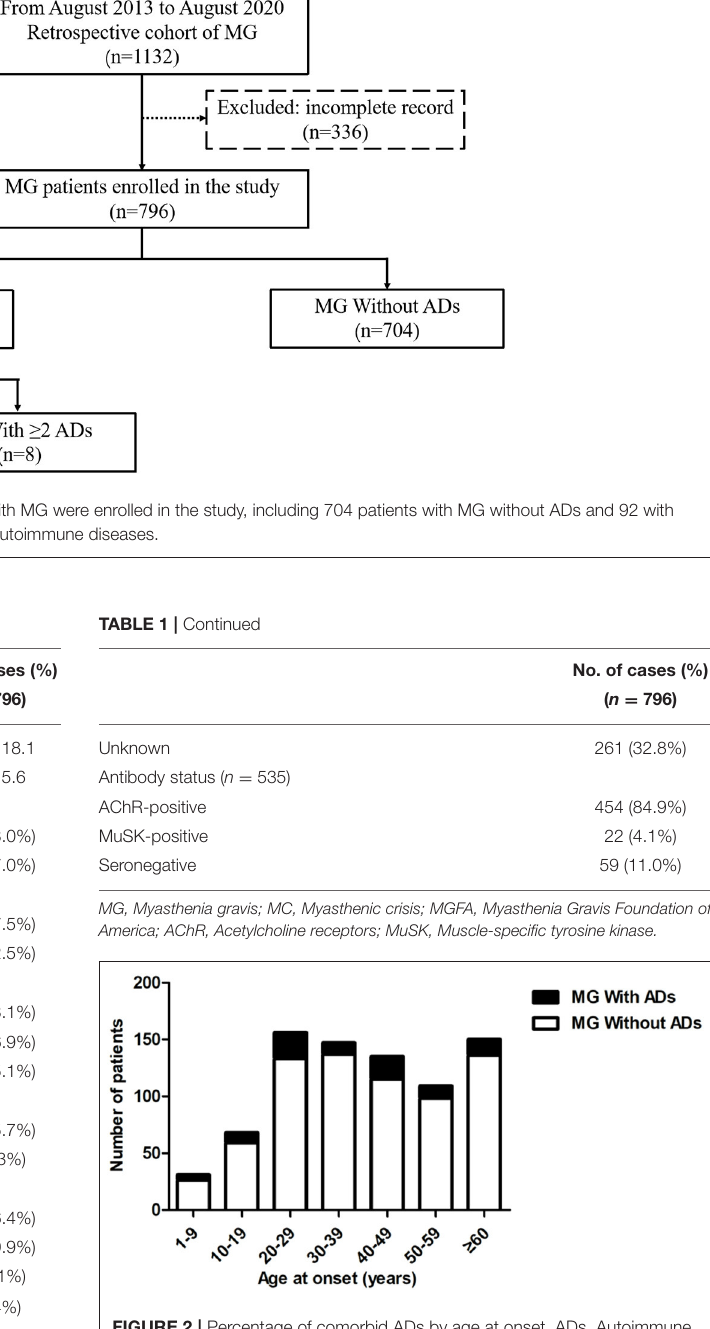
FIGURE 2 | Percentage of comorbid ADs by age at onset. ADs, Autoimmune diseases.